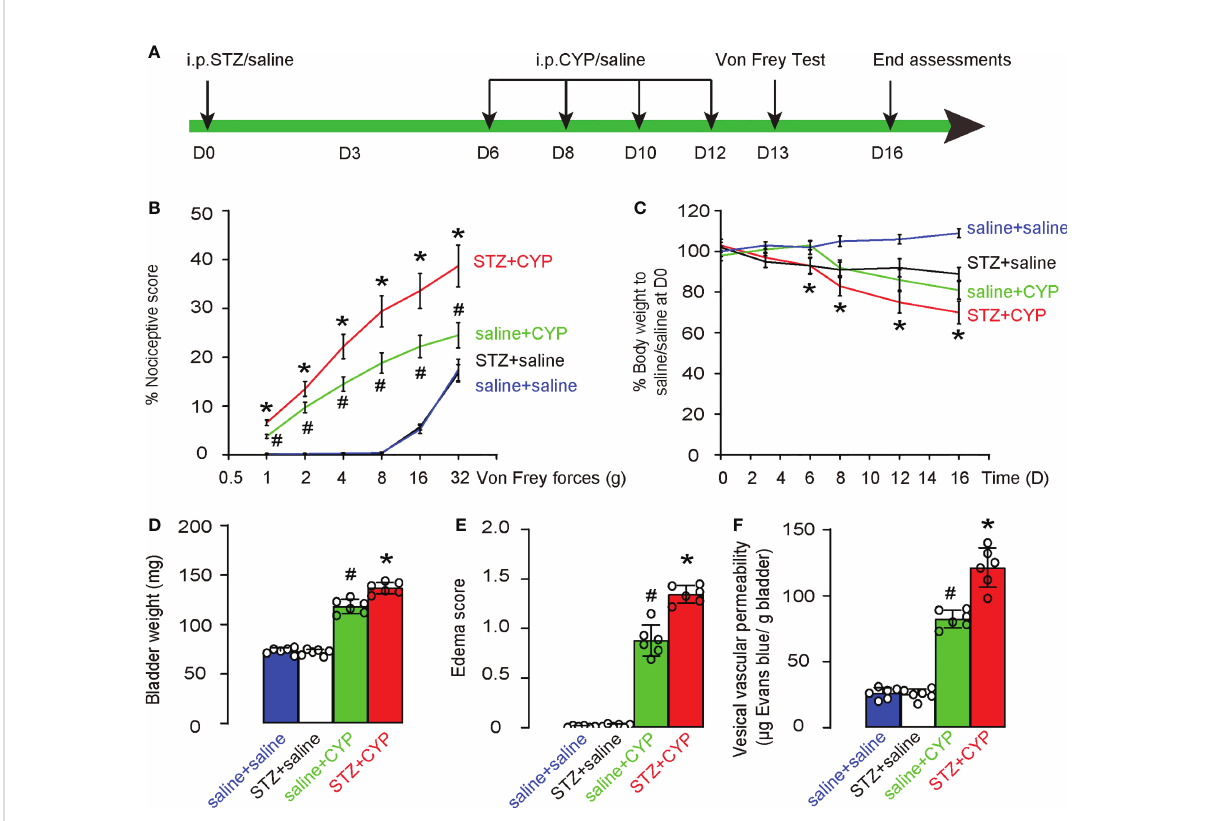
FIGURE 1 Diabetes aggravates CYP-induced cystitis. (A) Schematic of experiment: STZ was used at D0 to develop diabetes in mice. After 6 days when diabetes was con fi rmed, experimental cystitis was induced by 4 i.p. injection of CYP on D6, 8, 10 and 12. Von Frey test was done at D13, and mice were sacri fi ced at D16 for end assessments. (B-F) Four groups of mice were used. Group 1: mice received i.p. saline (control for STZ) at D0 and i.p. saline (control for CYP) at D6, 8, 10 and 12 (saline+saline); Group 2: mice received i.p. STZ at D0 and i.p. saline (control for CYP) at D6, 8, 10 and 12 (STZ+saline); Group 3: mice received i.p. saline (control for STZ) at D0 and i.p. CYP at D6, 8, 10 and 12 (saline+CYP); Group 4: mice received i.p. STZ at D0 and i.p. CYP at D6, 8, 10 and 12 (STZ+CYP). (B) Nociceptive score of the mice at Von Frey test at D13. (C) Changes in body weight. (D) Bladder weight at D16. (E) Edema score of the bladder at D16. (F) Vesical vascular permeability in bladder at D16. *p<0.05 (STZ +CYP vs saline+CYP). #p<0.05 (saline+CYP vs saline+saline or